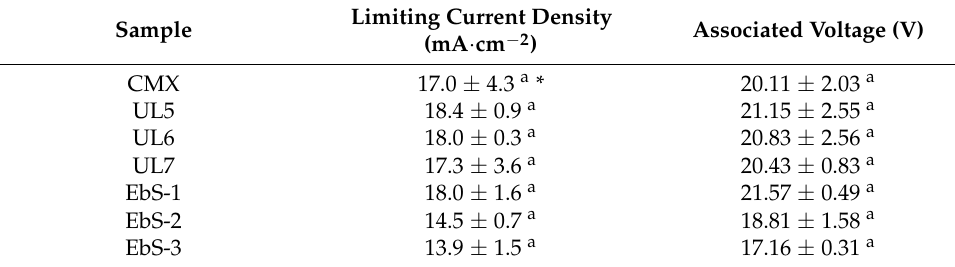
Table 4. Limiting current densities and voltages associated with the whole ED cell for each membrane.